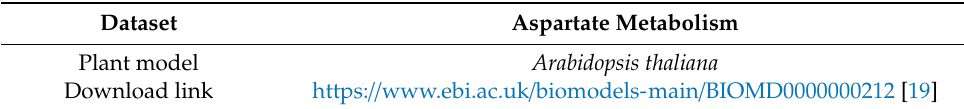
Table 1. Information on the dataset.